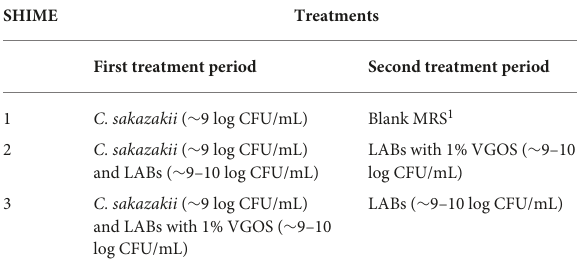
D 2 O, Chenomx Inc., Alberta, AB, Canada) was added to the final filtrate of each sample at a 1:10 (v/v) ratio to obtain a